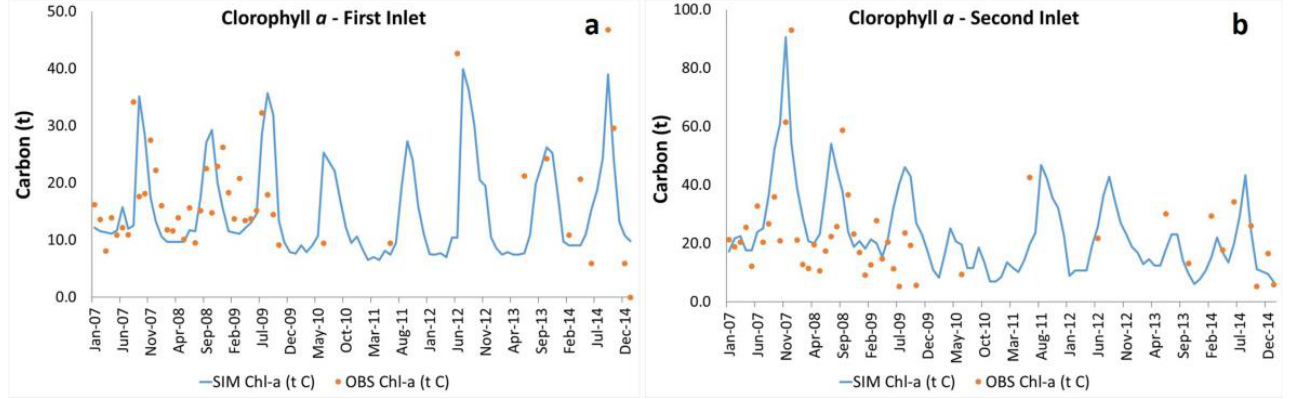
Figure 2. Chlorophyll a concentrations (t of Carbon) simulated (line) and field data (dots) in the First Inlet ( a ) and in the Second Inlet ( b ) of Mar Piccolo.